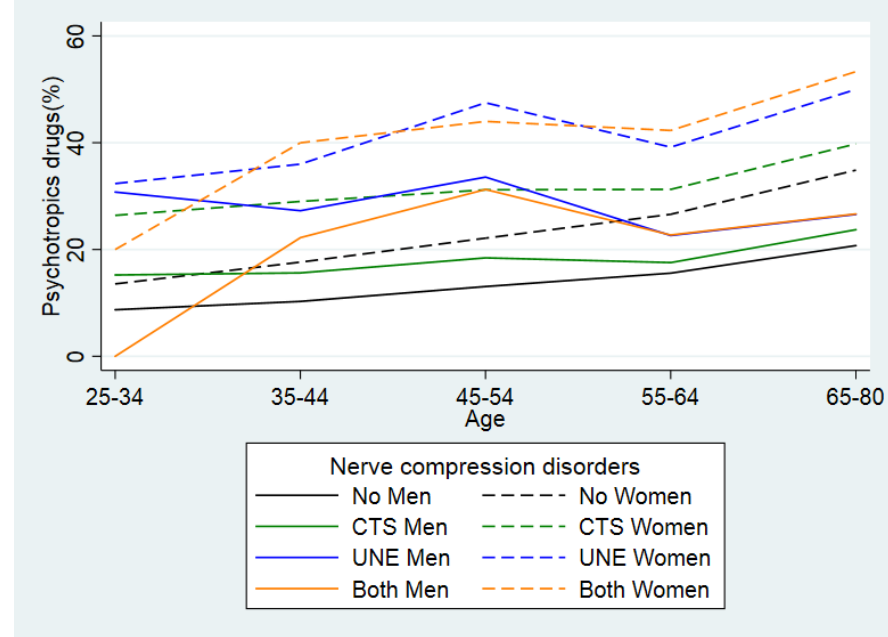
Figure 2. Age stratified percentage of use of psychotropic drugs in men and in women, residing in Sweden 2010, and suffering from carpal tunnel syndrome (CTS), ulnar nerve entrapment (UNE) and both disorders as well as in people without any nerve compression disorder.